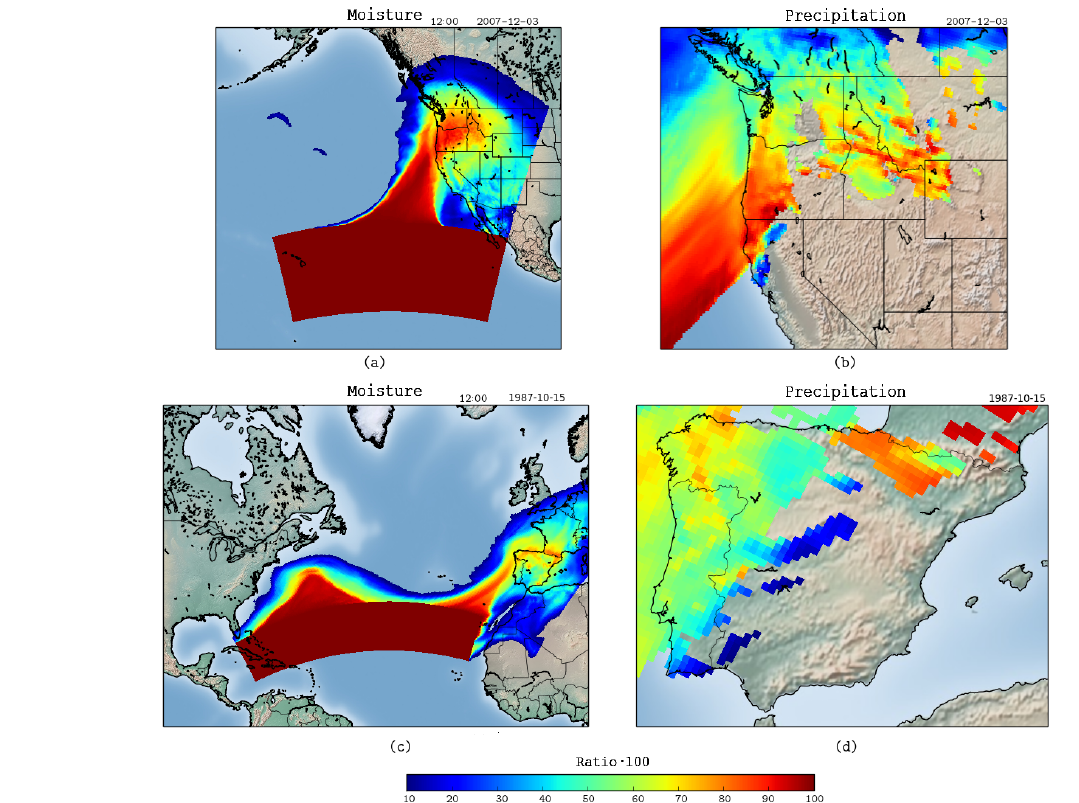
Figure 7. (a) Ratio of tagged water vapor to total water vapor for the Pacific event. (b) Same as (a) but for precipitation. Panels (c, d) are equivalent to (a, b) , respectively, but for the Atlantic